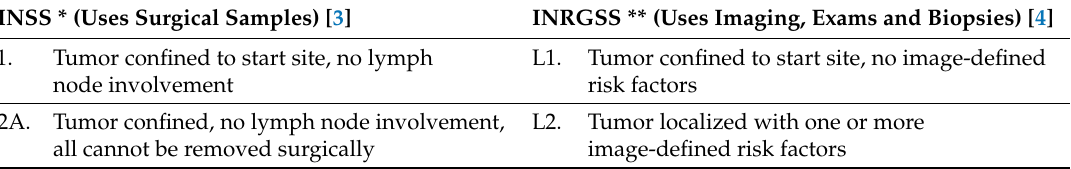
Table 1. Classification of